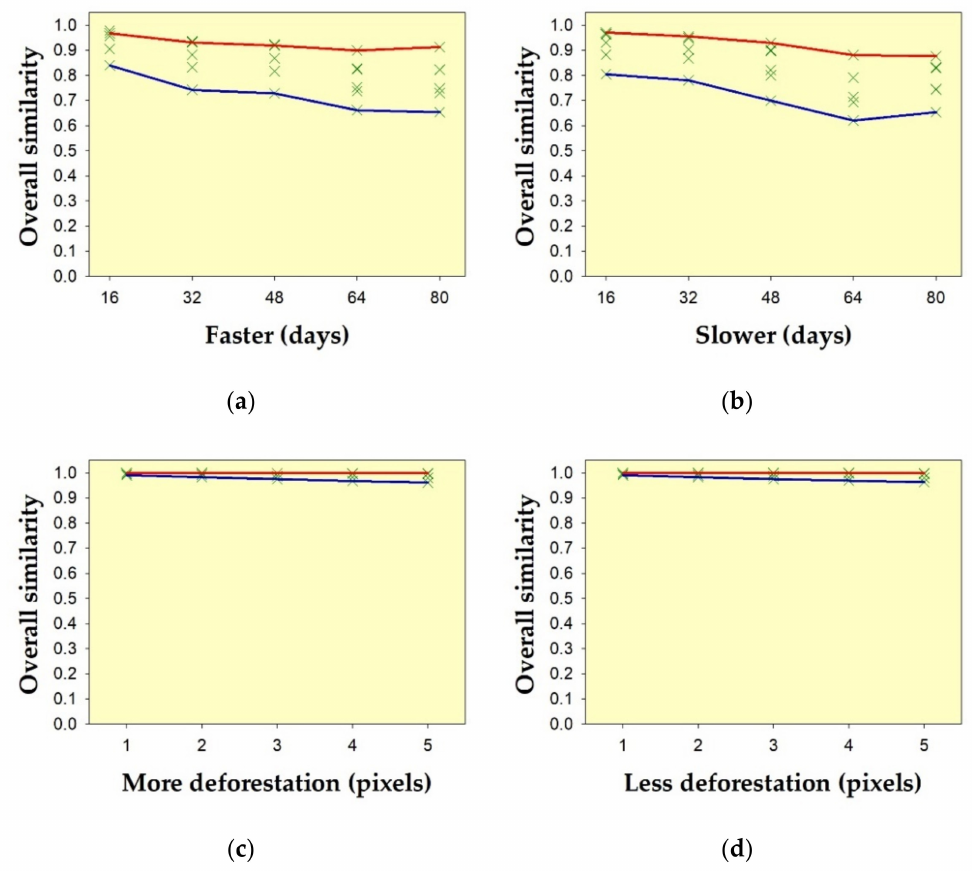
Figure 23. Sensitivity of the method on hypothetical temporal data sets on deforestation after interpolation at a time slice of 1 h, due to the possibility of ( a ) acceleration, ( b ) delay, ( c ) overestimation, and ( d ) underestimation of deforestation detection, compared to the reference. Green crosses indicate overall similarity (i.e., the average of θ and δ similarities) from all nine metrics. Red lines on the upper edge of the envelopes indicate the overall similarity using the Fidelity metric. Blue lines on the lower edge of the envelopes indicate the overall similarity using the metric of